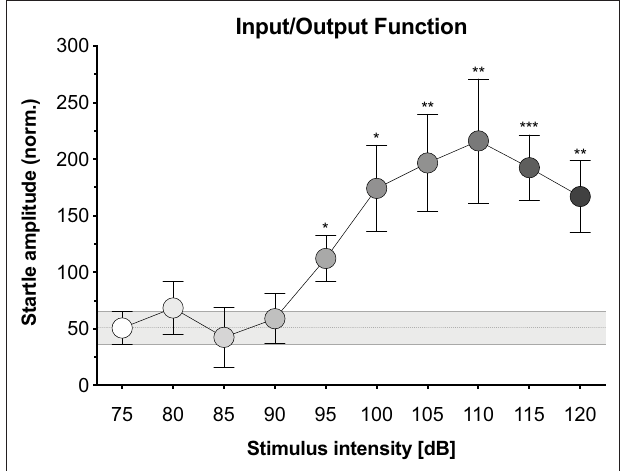
FIGURE 1 | Input/output function. The relationship between acoustic stimulus intensity and startle response amplitude for our hybrid mice. Acoustic stimuli were white noise bursts (200ms with 0ms rise time) of increasing intensities (four trials at 75 dB then single trials at 80–120 dB). Normalized startle amplitude was significantly enhanced at the 95, 100, 105, 110, 115, and 120 dB noise bursts relative to the 75 dB noise burst. Each point represents the mean ± 1 standard error. The gray bar indicates standard error range for the comparison 75 dB noise burst. Data points with asterisk identify significant comparisons against the 75 dB noise burst using Fisher’s LSD (* P < 0.05, ** P < 0.01, and *** P <